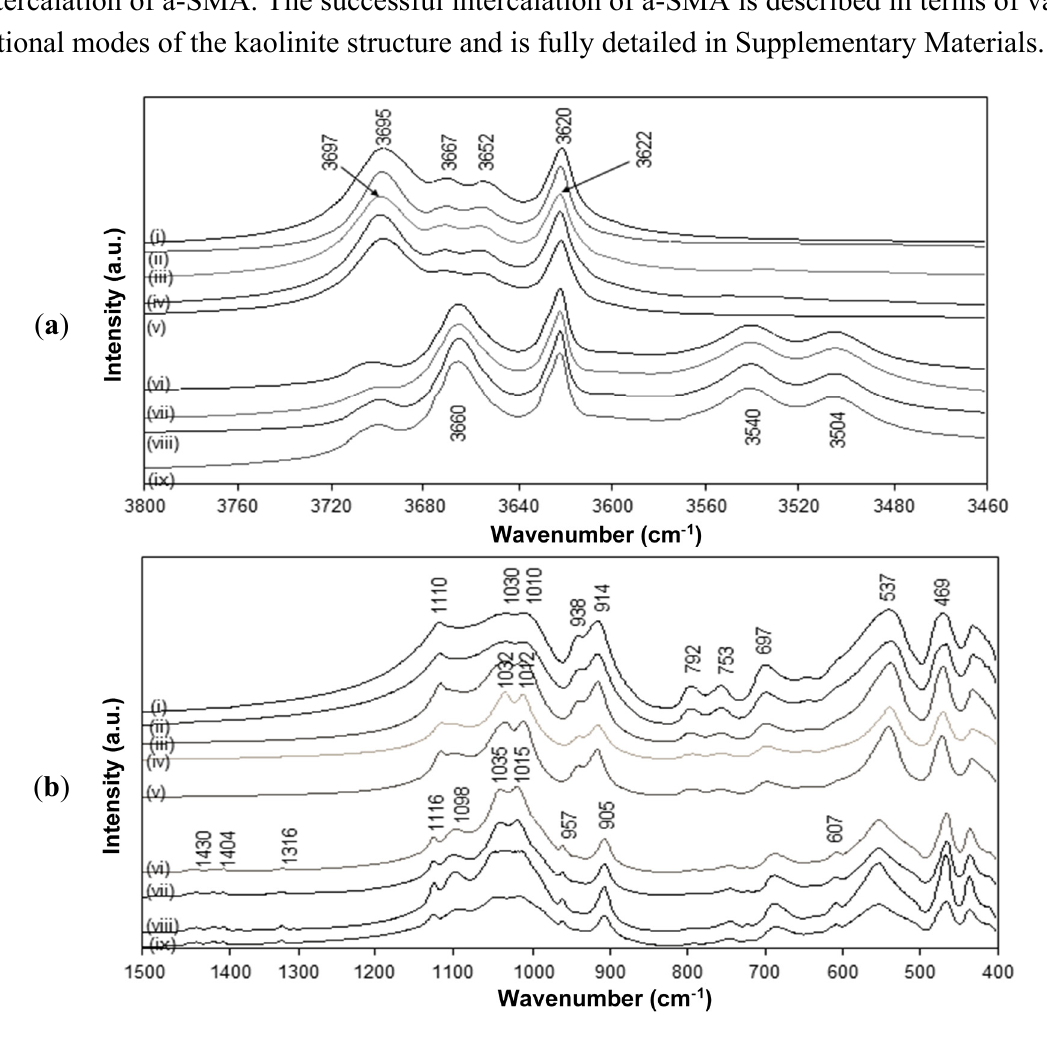
Figure 5. FTIR spectra characteristic for ( a ) O–H stretching region, ( b ) lattice vibrations